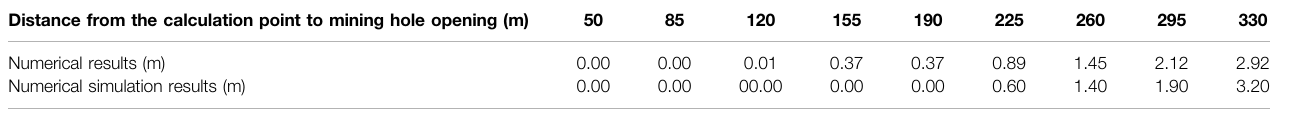
TABLE 9 | Inelastic zone width for the coal pillar calculated by numerical calculation and numerical simulation under the 0% fi lling rate condition. Distance from the calculation point to mining hole opening (m) 50 Numerical results (m)